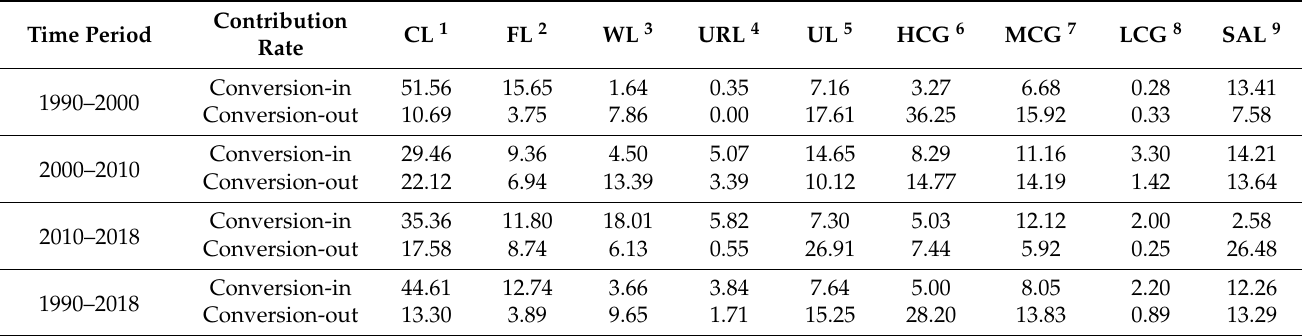
Table 1. The contribution rates of conversion-in and conversion-out for land use types during 1990–2018